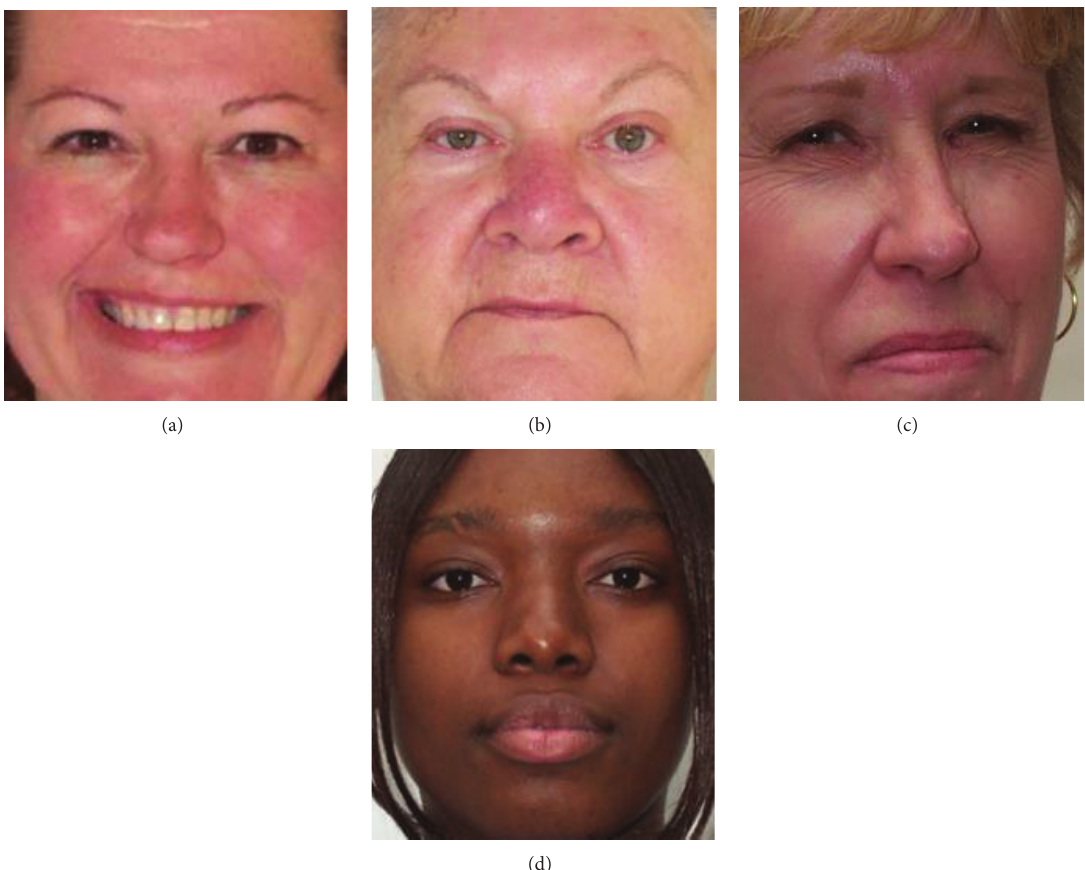
Figure 15: Example of estimation results of the female database: (a) ground-truth age of 42, estimated age of 43, (b) ground-truth age of 70, estimated age of 70, (c) ground-truth of 53, estimated age of 72, and (d) ground-truth of 20, estimated age of 36.